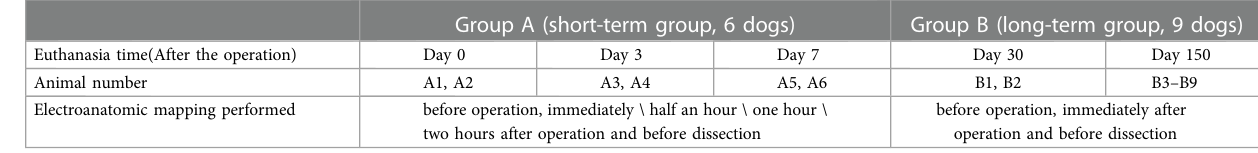
Group A (short-term group, 6 dogs)